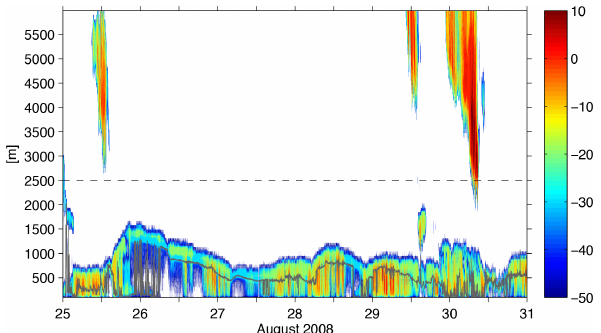
Fig. 1. Cloud reflectivity (contours, [dBZ]) observed from the ver- tically pointing MMCR radar at ASCOS over the week 25–30 Au- gust 2008. The MMCR is sensitive to hydrometeor size, and often reflectivities larger than − 17dBZ are representative of larger driz- zle or ice hydrometeors. The lowest cloud base observed from the ceilometer (gray) overlays the cloud radar reflectivity; the ceilome- ter is sensitive to the liquid cloud base height. Thus reflectivities be- low cloud base indicate hydrometeors falling from the liquid cloud. Only low-level clouds below 2500ma.g.l (dashed horizontal line) are examined in this study.